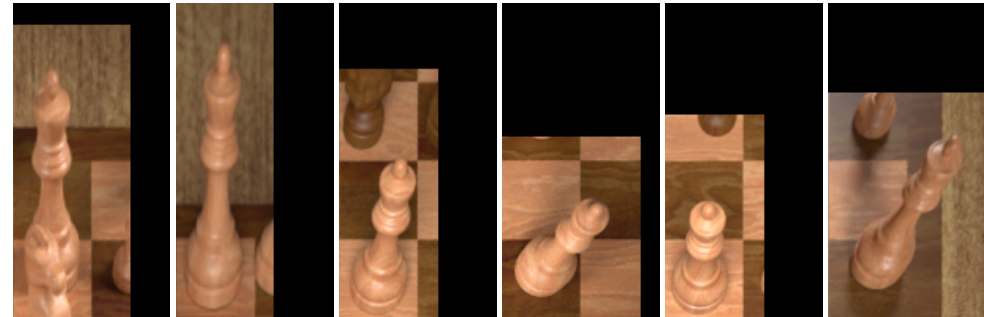
Figure 8. A random selection of six samples of white queens in the training set. Notice that the square each queen is located on is always in the bottom left of the image and of uniform dimensions across all samples.